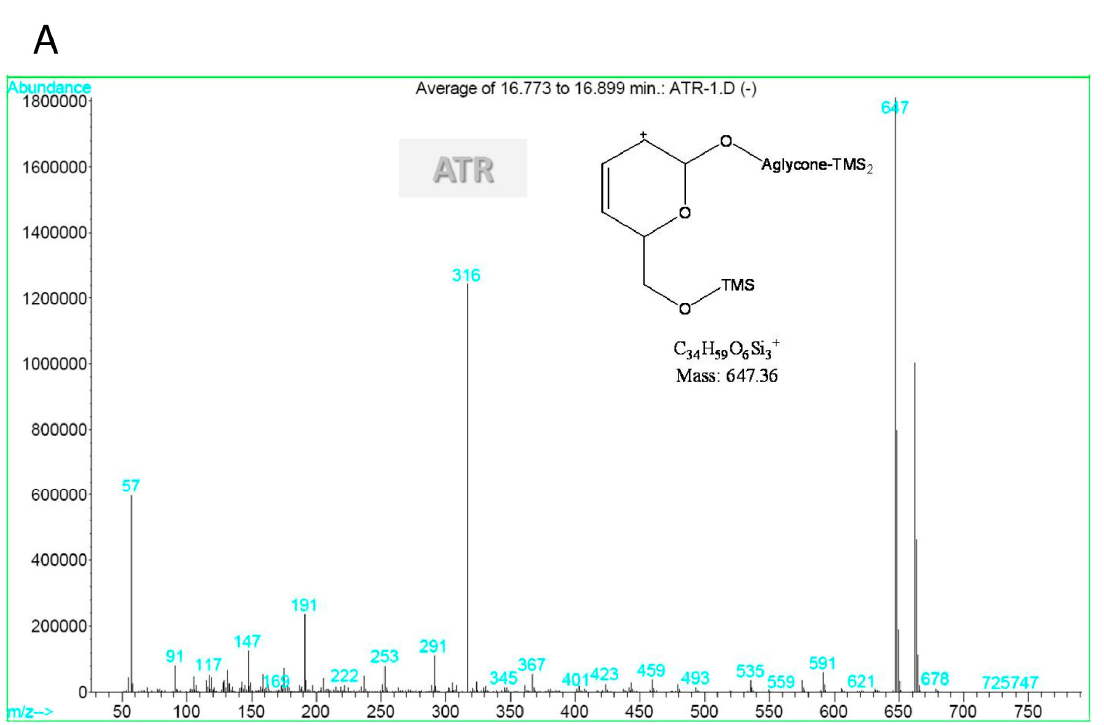
Figure 4. Mass spectra of ATR ( A ) and H+ATR ( B